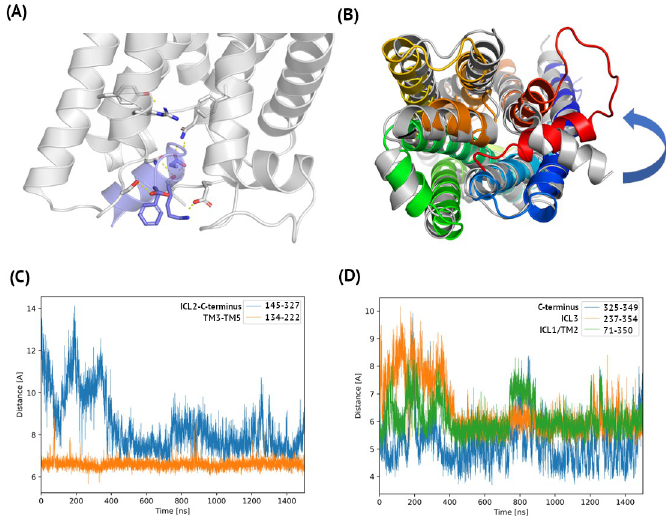
Fig 3. Polar interactions in the complex of C5aR1 and G α . Here, 1.5 microsecond MD simulations of active C5aR1 was used to analyze the distances between the centers of mass of the amino acids. In (A) a hydrogen bonding network stabilizing the C5aR1 –G α interface was shown: Asn71 –Asp350, Glu325 –Lys349, Ser237 –Phe354 (C-cap only) in C5aR1 and G α , respectively. In addition, intrareceptor interactions were shown: Arg134 –Tyr222 and Gln145 –Ser327. These intrareceptor polar interactions stabilized the TM3 –TM5 interface and the ICL2 –C-terminus region. In (B) the C5aR1 –G i complex refined in microsecond MD was superposed on the FPR2 template (6OMM, an intracellular view). The TM core of C5aR1 was shown in blue-to-red (with the C-terminus of G α in orange) and FPR2 was shown in grey. During simulations, the C-terminal helix of G α did not change in comparison with the FPR2 template. The C- terminus of H8 in C5aR1 stayed as close to G α as H8 in FPR2, but its N-terminus was slightly rotated with respect to FPR2. (C) Distance plots for intrareceptor interactions. After ca. 400 ns of the simulation Ser327 (C-terminus of C5aR1) formed interactions with Gln145 (ICL2). The close distance TM3—TM5, represented by the distance between residue 134 (the ‘DRF’ motif—equivalent of ‘DRY’) and 222, was observed during the whole simulation. (D) Distance plots for C5aR1 –G α interactions. Also in this case, after ca. 400 ns Ser237 (ICL3) formed a stable interaction with C- cap of Phe354 (G α ). Interacting Asn71 (TM2) and Asp350 (G α ) additionally stabilized the complex. The least distance, between Lys349 (G α ) and Glu325 (C5aR1 C-terminus), was kept and did not change during the whole 1.5 μ s simulation. Here, sequence numbering was adjusted to P21730 and P63096 entries in Uniprot.